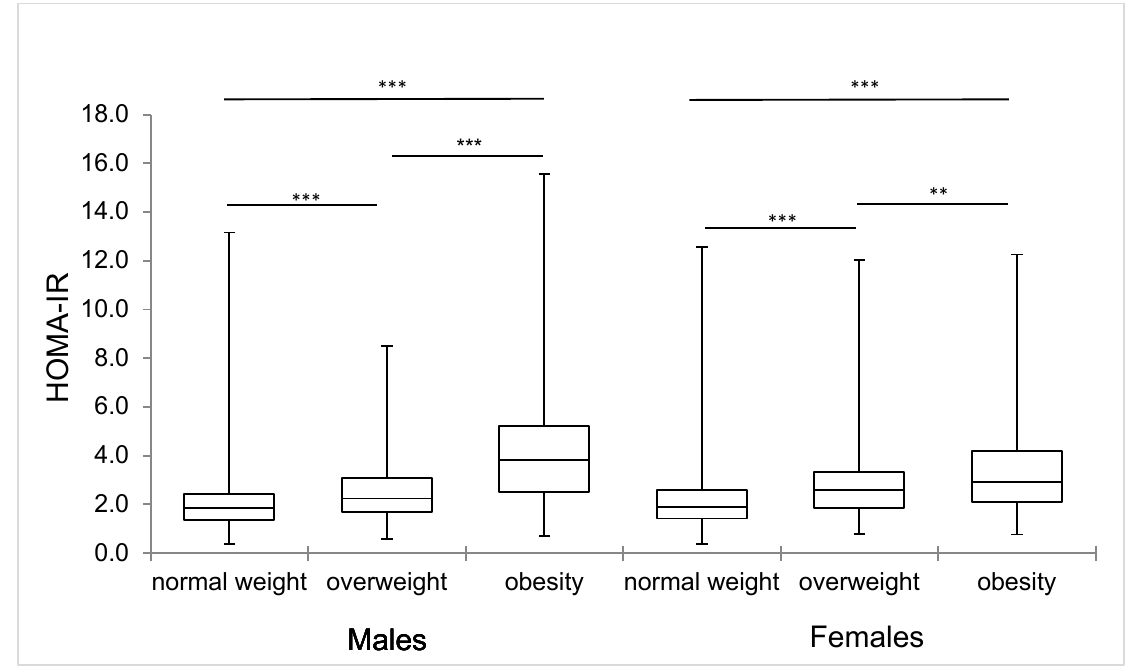
Figure 2. HOMA-IR values box-plot representation considering median values and 25–75 percentile distributions according to BMI categories and the pair-wise comparison. *** p = 0.000; ** p = 0.004.